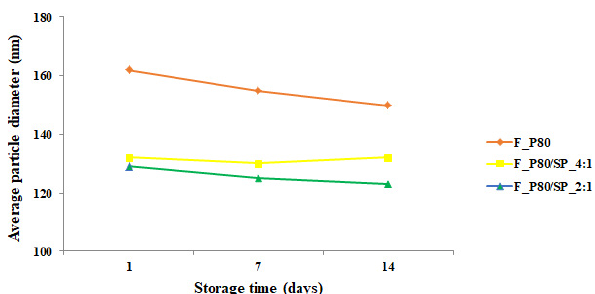
Figure 5: Short-terms physical stability assessment of the investi- gated curcumin nanocrystal dispersions